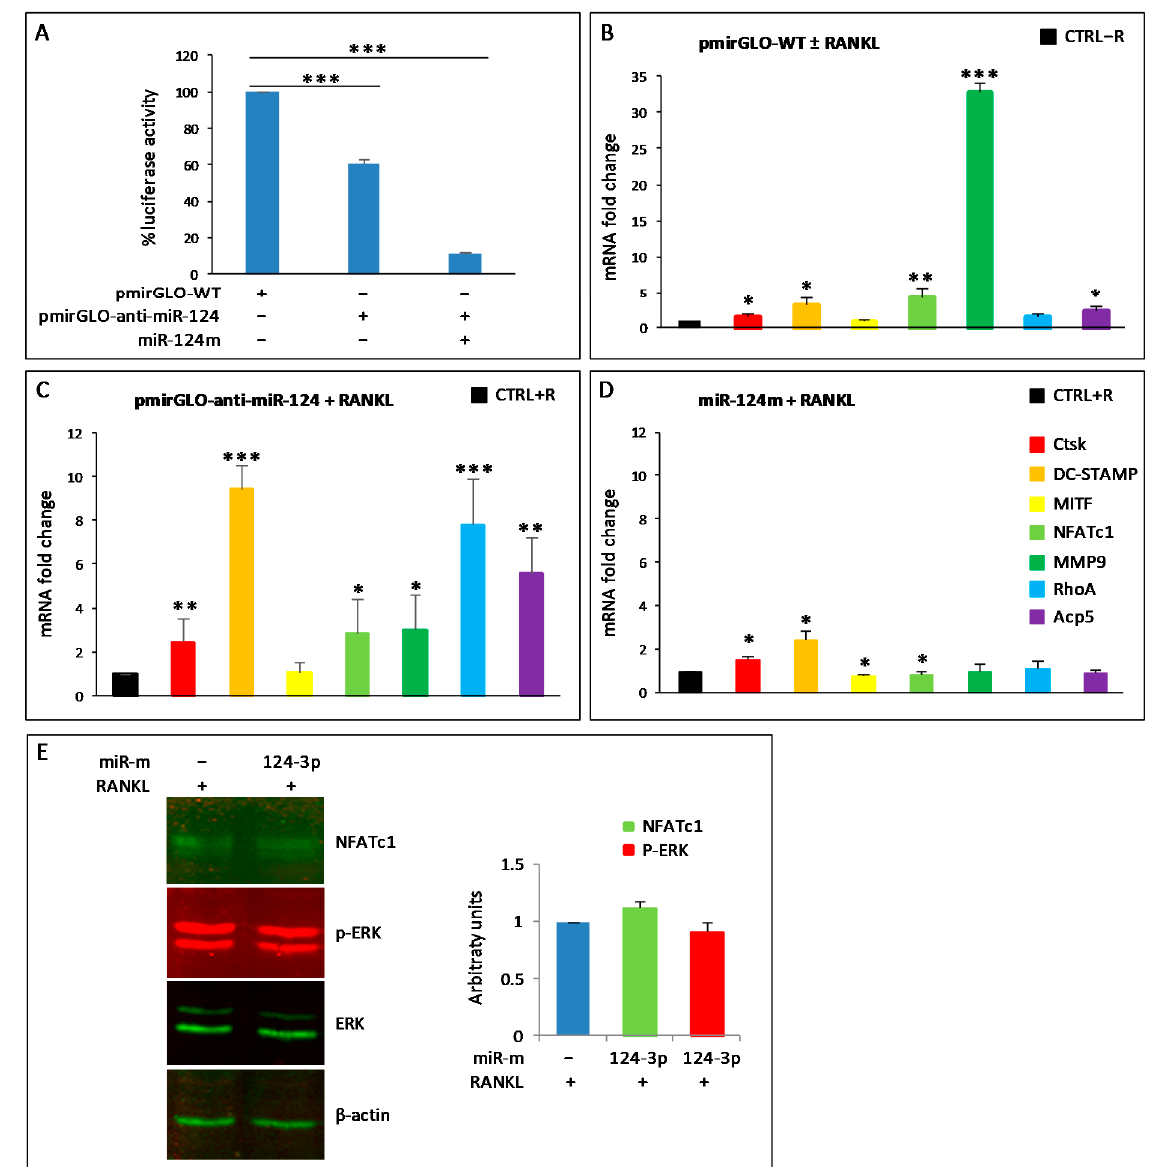
Figure 3. miR-124-3p expression in RAW264.7 cells. ( A ) RAW264.7 cells were transfected with control pmiRGLO-empty (WT) or pmiRGLO-anti-miR-124 without or with miRNA-124 mimic (miR-124m) and then RANKL-stimulated for 24 h. Luciferase assays were performed. The results shown are the means ± SD of five experiments (each of which was performed in triplicate). *** p < 0.001 each transfection versus control. ( B , C , D ) QPCR analyses were performed to evaluate the mRNA expression of CtsK , DC-STAMP , MITF , NFATc1 , MMP9 , RhoA , and Acp 5/ TRAP (see color legend in D ). ( B ) RAW264.7 cells were transfected with control pmiRGLO-empty (pmiRGLO-WT), in the absence or presence of RANKL (± RANKL) for 24 h, and those without RANKL (CTRL − R) served as control. The results are shown as relative values of pmiRGLO-WT transfected cells with +RANKL vs. CTRL − R, arbitratily set at 1. ( C ) RANKL-stimulated cells (+RANKL) were transfected with pmirGLO-anti-miR-124, for 24 h. RANKL-stimulated cells transfected with control pmiRGLO-empty (pmiRGLO-WT) served as control (CTRL+). The results are shown as relative values of cells transfected with pmiRGLO-anti-miR-124 vs. those transfected with pmiRGLO-WT arbitratily set at 1. ( D ) RANKL-stimulated cells (+RANKL) were transfected with miR-124 mimic (miR-124m) for 24 h. RANKL-stimulated cells transfected with negative control (CTRL + R) served as control. The results are shown as relative values of cells transfected with miR-124m vs. those transfected with CTRL + R arbitrarily set at 1. GAPDH was used as a housekeeping gene in the qPCRs shown in ( B ), ( C ), and ( D ), and the results are the means ± SD of three experiments (each of which was performed in triplicate). * p < 0.05, ** p < 0.01, and *** p < 0.001, each agent alone versus control. ( E ) RANKL-stimulated cells (+RANKL) were transfected with negative control ( − ) or miR-124 mimic (124-3p) for 24 h. Western blots were performed to evaluate the levels of NFATc1, ERK1/2, and p-ERK1/2. β -actin was a loading control. The data shown are representative of two independent experiments with comparable outcomes. The histogram shows the protein levels for NFATc1, normalized using β -actin, and